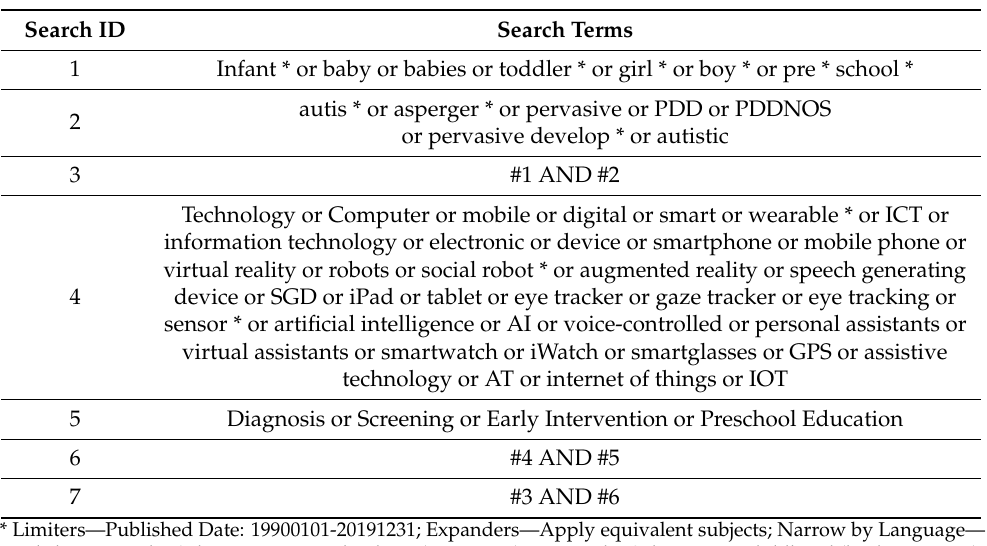
Table A2. EBSCO and Web of Science (WoS) search